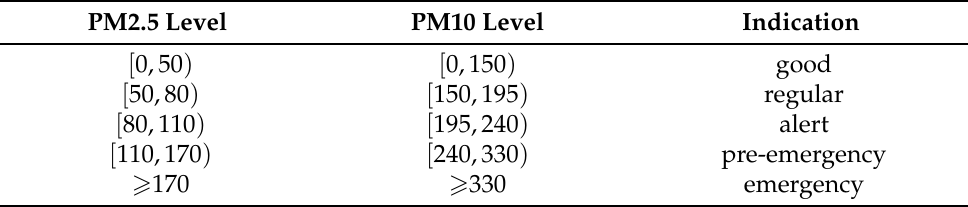
Table 7. Primary quality guidelines for PM2.5 and PM10 levels in 24 h